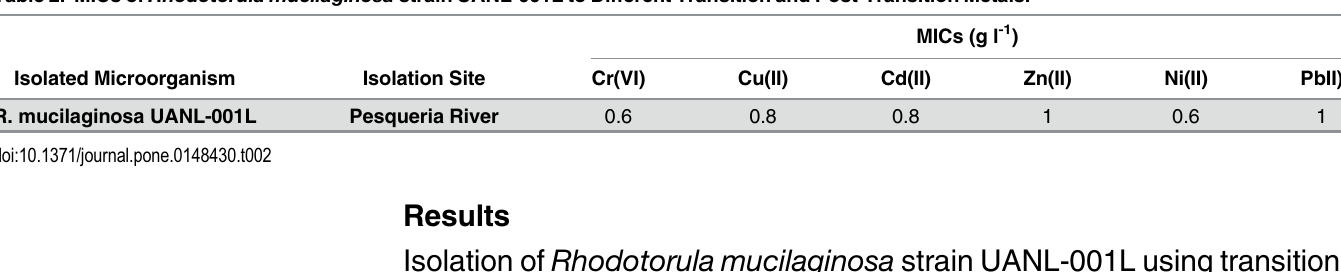
Table 2. MICs of Rhodotorula mucilaginosa strain UANL-001L to Different Transition and Post-Transition Metals.